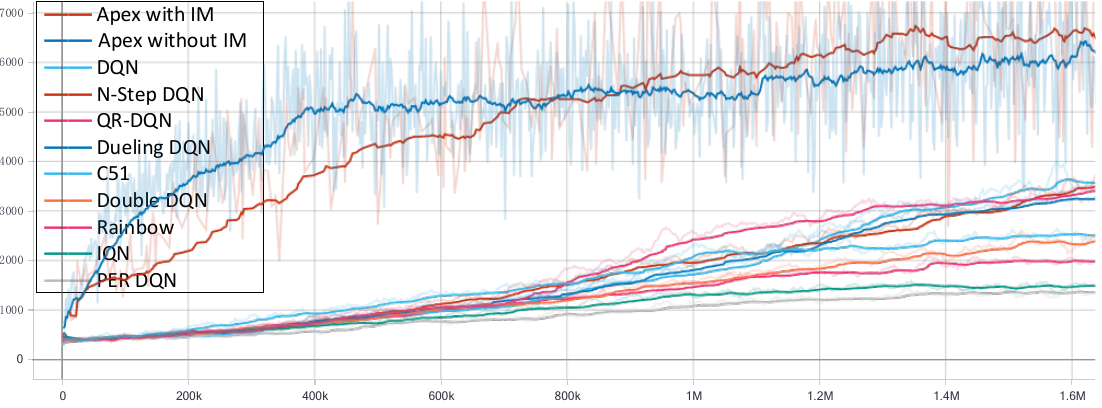
Figure 8. The experimental results achieved in this study compared with those obtained by other reinforcement learning algorithms.